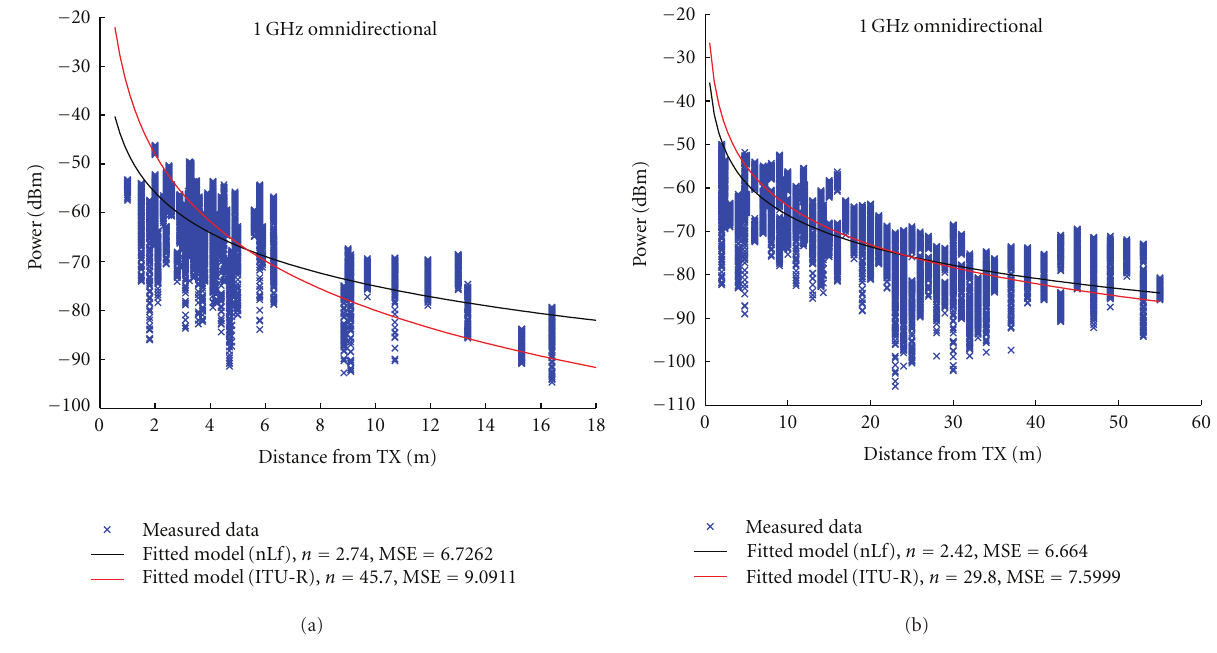
Figure 2: Signal power variation with distance at 1.3GHz for measurements (a) within rooms and (b) along a corridor. Table 2: Values of path loss exponent ( n ) for measurements in di ff erent indoor